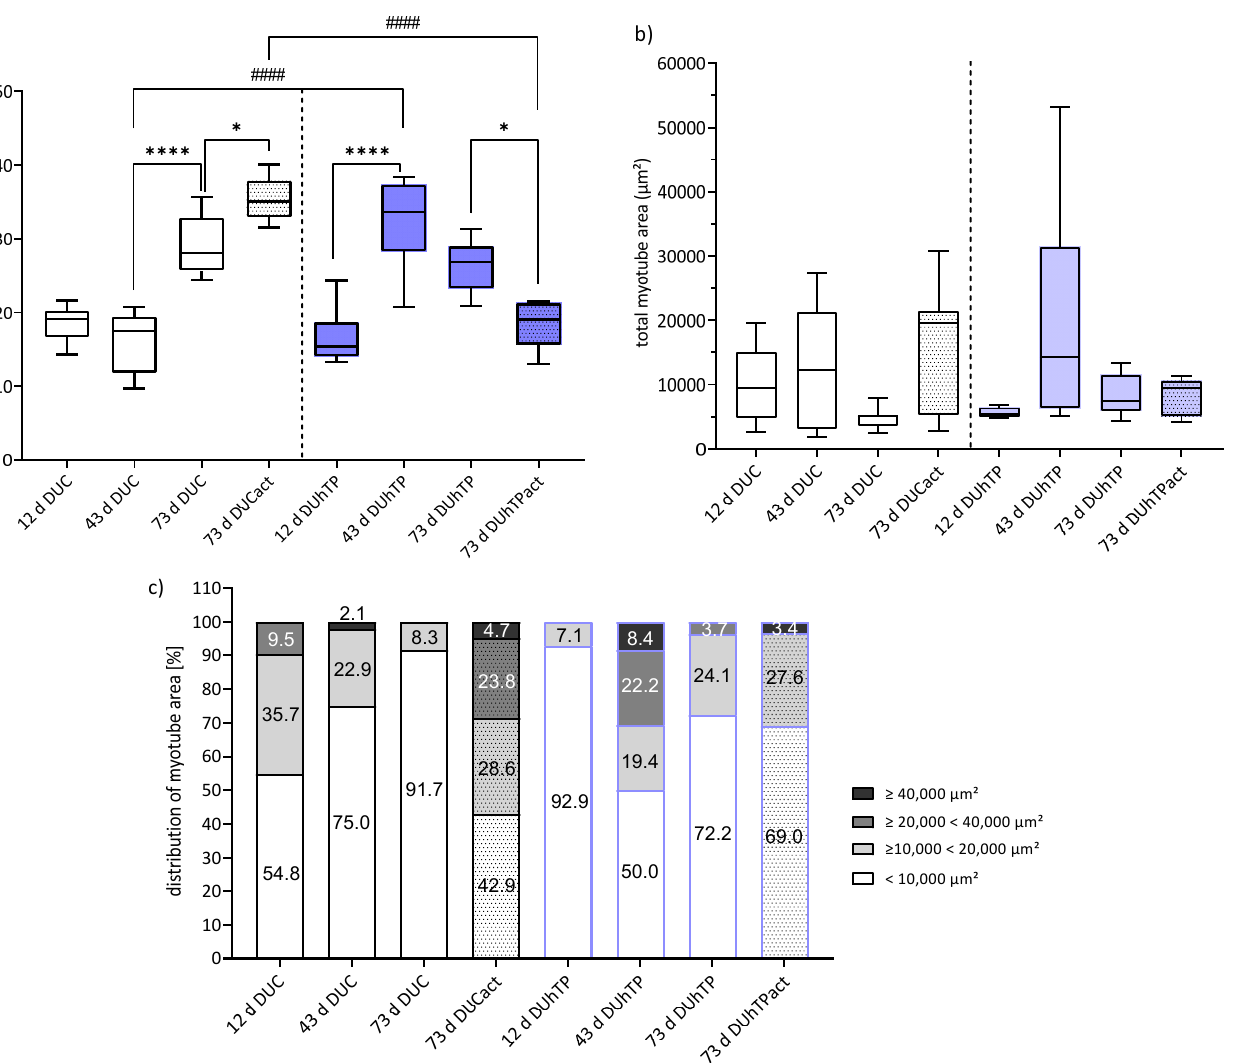
Figure 6. Fusion index and myotube size distribution of differentiated MPC/SATC. Myosin heavy chain immunofluorescence images were performed to quantify ( a ) the fusion index as the percentage of total nuclei being localized in fused multinucleated cells, ( b ) the area covered by myotubes (µm 2 ), and ( c ) the myotube size distribution (%). All parameters are determined 72 h after induction of differentiation. Myotubes with a size of <10,000 µm 2 were classified as small myotubes, whereas myotubes ≥10,000 <20,000 µm 2 were grouped as middle-sized, ≥20,000 <40,000 µm 2 as large myo- tubes, and ≥40,000 µm 2 as very large myotubes. Significant line-specific differences between DUC (left; consistent of single animal and pool cultures representing: 12 d: 7 mice, 43 d: 9 mice, 73 d: 27 mice, 73 d act: 25 mice) and DUhTP (right; consistent of single animal and pool cultures representing: 12 d: 15 mice, 43 d: 25 mice, 73 d: 13 mice, 73 d act: 5 mice) lines are separated by hashtags ( #### p < 0.0001). Significant age-related differences within each line are separated by asterisks (* p < 0.05, **** p <